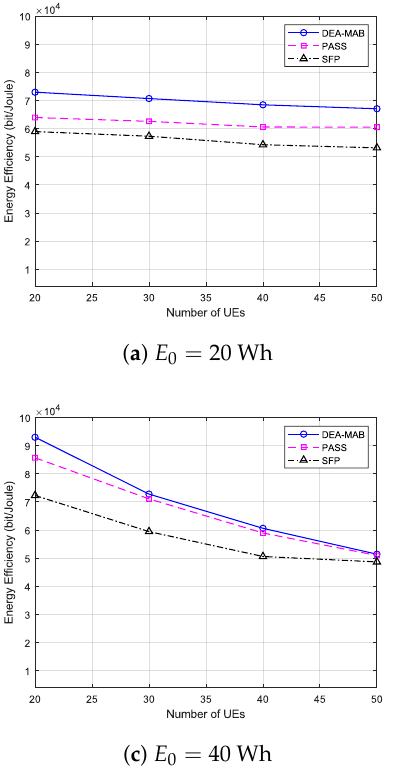
Figure 5. UEs’ energy efficiency versus the number of